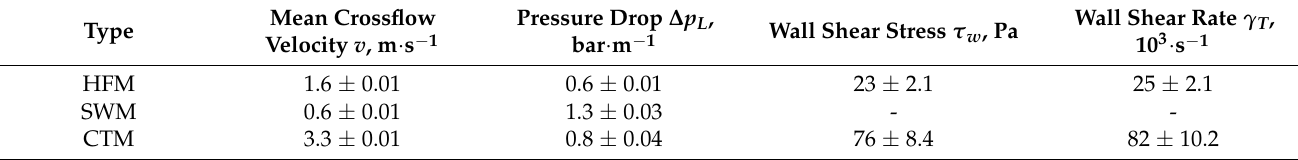
Table 3. Mean crossflow velocity, v , the resulting pressure drop, ∆ p L , the wall shear stress, τ w , and the wall shear rate, γ T , for spiral wound membrane (SWM), ceramic tubular membrane (CTM), and hollow fiber membrane (HFM) at a feed . V = 20 m 3 · h − 1 volume flow of